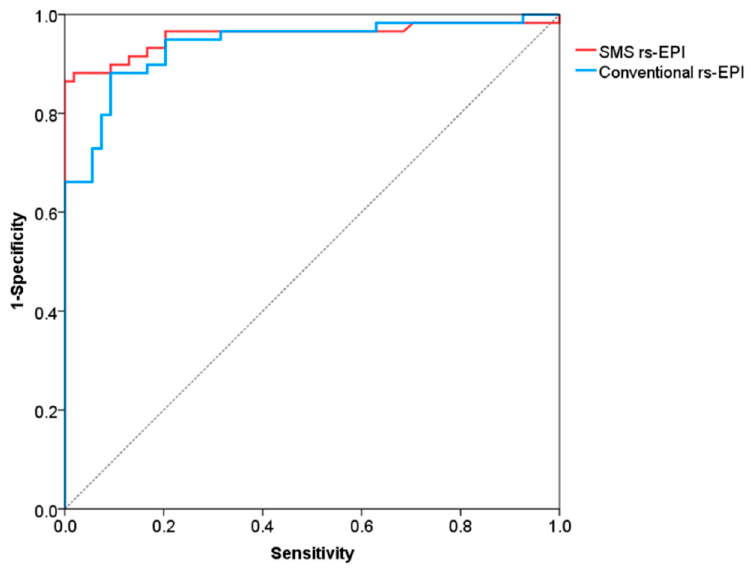
Figure 6. Receiver operating characteristic curves for differentiation of malignant and benign le- sions.